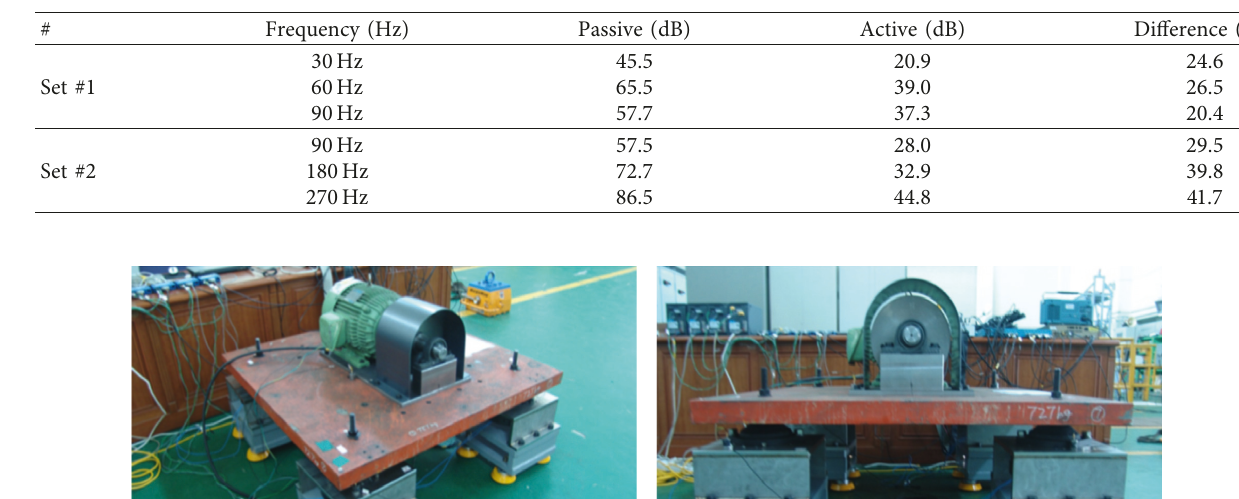
Figure 16: Experimental results of vibration reduction while applying hybrid mount. (a) Set #1: 30, 60, and 90 Hz. (b) Set #2: 90, 190, and 270Hz. Table 9: Measurement results of vibration reduction when applying the hybrid mount.